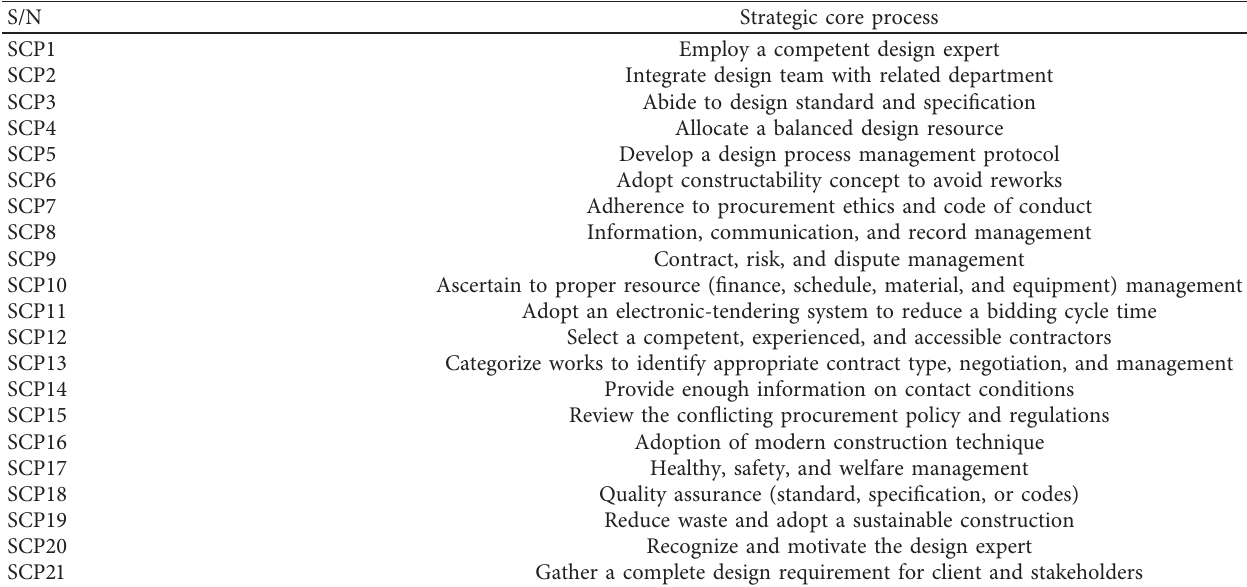
Table 5: Selected strategies for construction core process (SCP) considered in this